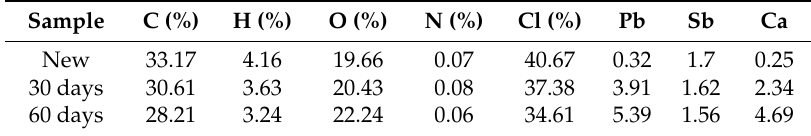
Table 1. Elemental analysis of new and aged cable sheaths.